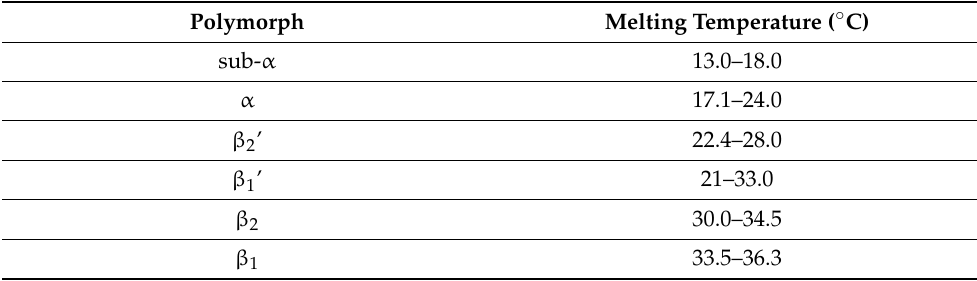
Table 2. Ranges of melting points of the different polymorphs of cocoa butter